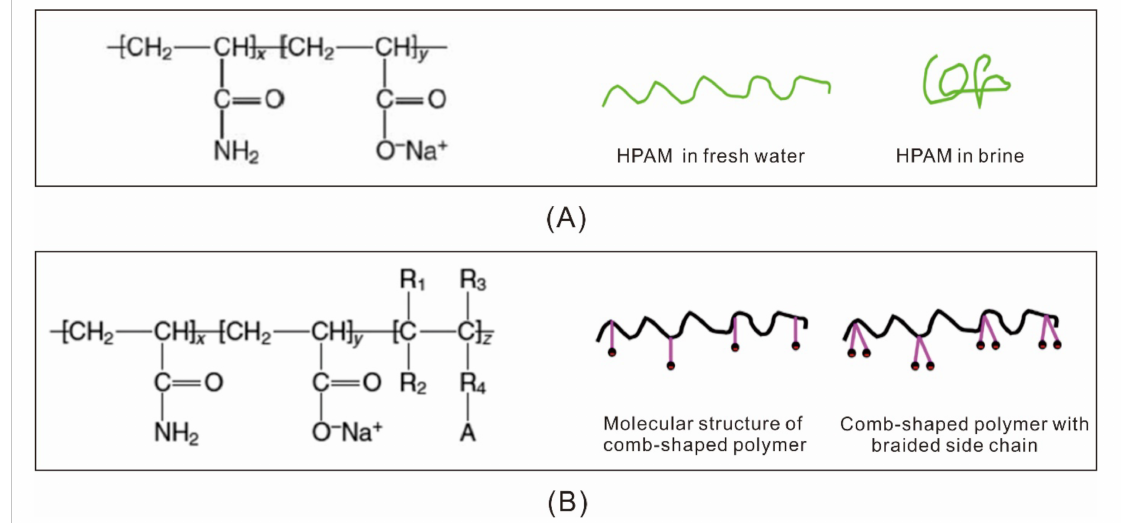
Figure 8. Chemical structure of hydrolyzed polyacrylamide ( A ) and comb-type polymer ( B ) (revised after